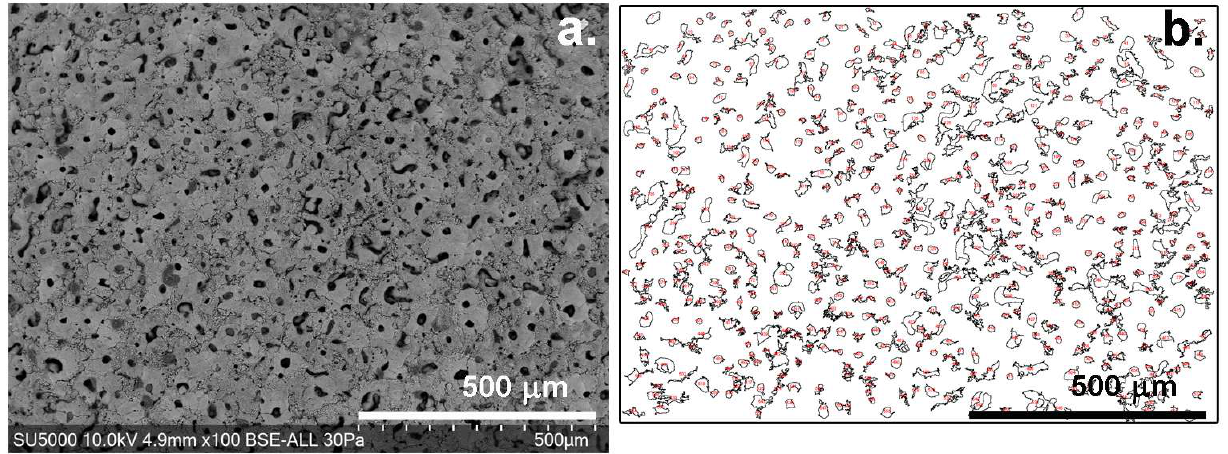
Figure 3. Example of a used SEM image ×100 ( a ) and ImageJ pore identification ( b ) of the sample AZ63_10m surface. Table 1. Mean porosity values of the PEO treated